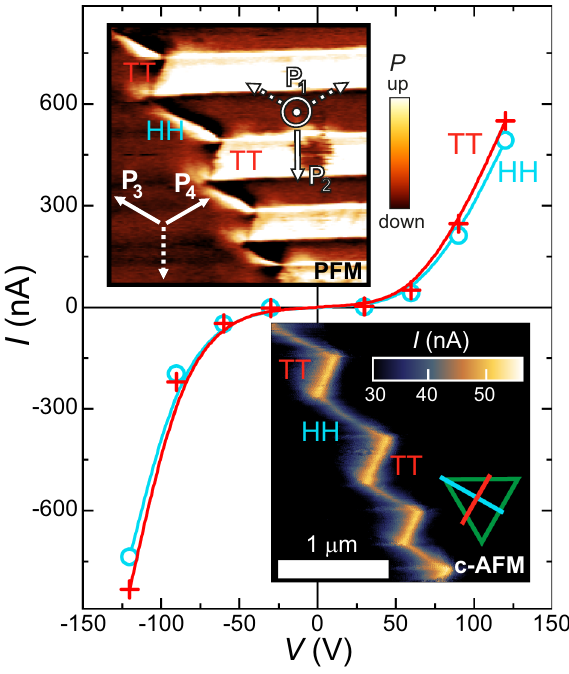
Fig. 3 I – V characteristics of conductive DWs. I – V characteristics of HH (cyan) and TT (red) conductive DWs at 15K. The solid lines are guides to the eye. A c-AFM image recorded at + 60V at 15K is displayed at the bottom inset. The upper inset displays a PFM image recorded on the same area (see Supplementary Fig. 2 for an extended version of the PFM image). The arrows in the PFM image indicate the orientations of the polar axis of four polar domain states and the schematic triangle in the c-AFM image indicates the orientation of the conductive HH and TT DWs within the (111) plane.